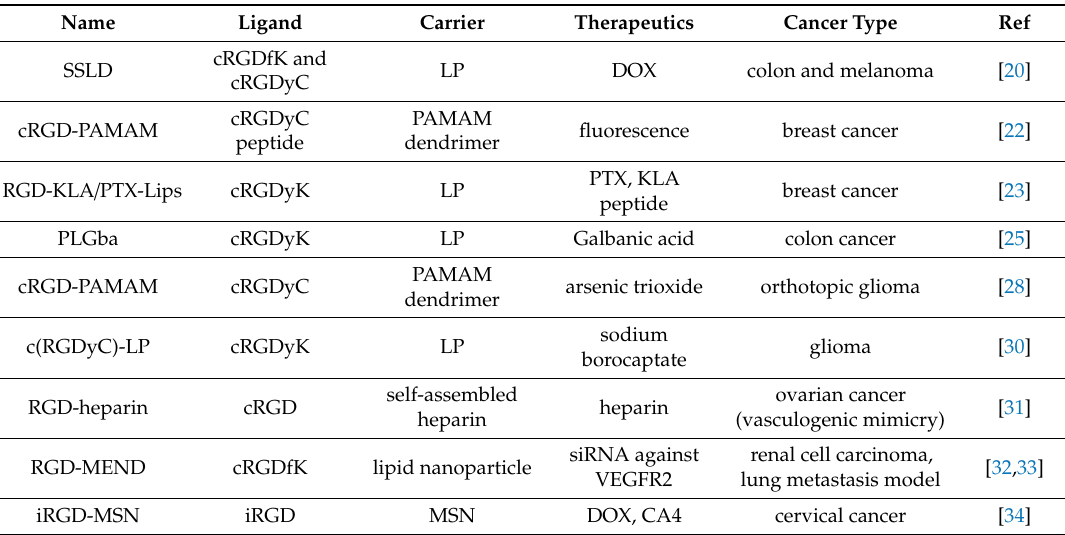
Table 1. RGD-modified